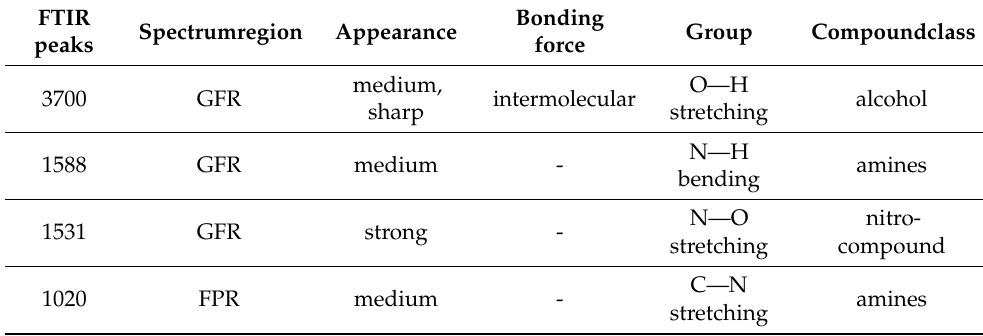
Figure 3. FTIR spectra of (a) Cr 0.20 ZnS, (b) Cr 0.25 ZnS, and (c) Cr 0.30 ZnS catalyst samples. Table 1. FTIR peaks and corresponding groups of the Cr x ZnS catalyst.